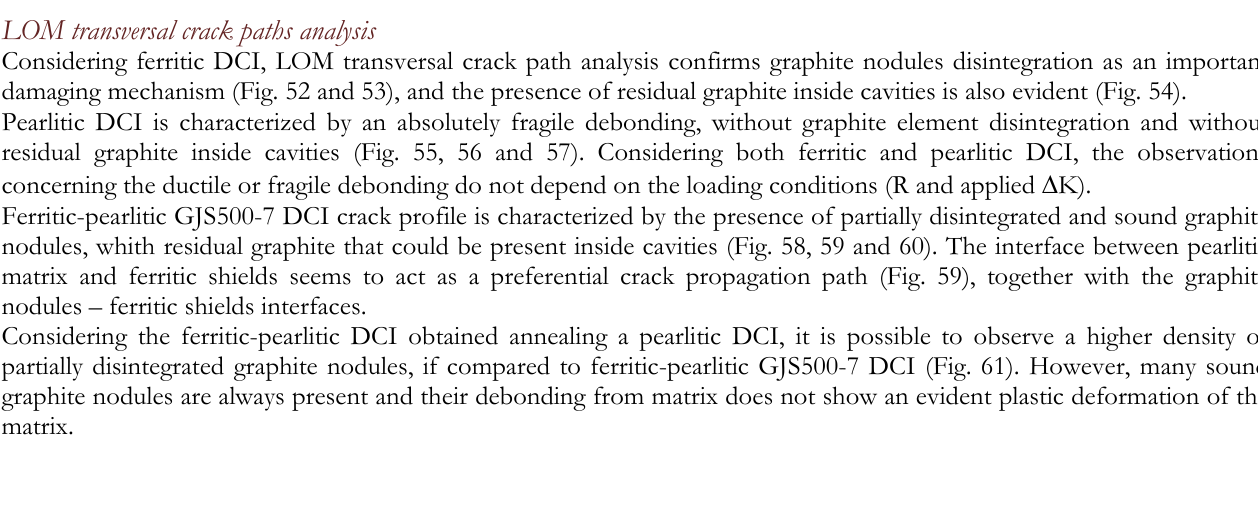
Figure 50: Four investigated ductile irons. Approximation sphere diameter – void diameter.